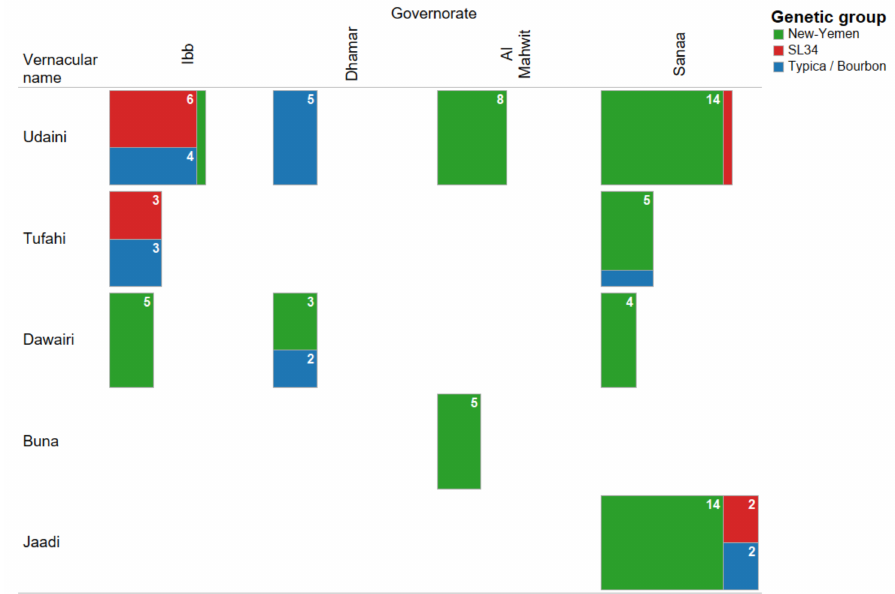
Figure 6. Genetic make-up of 88 coffee samples along with their vernacular name and the governorate of